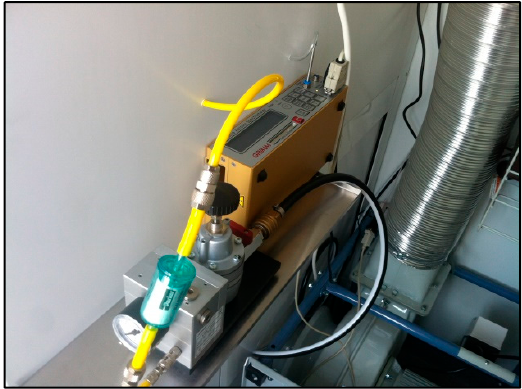
Figure 3. Aerosol spectrometer (yellow box) and pressure regulator with pressure indicator of the VKL mini. The dilution system VKL mini attenuates the sampled air in a ratio of 1:10 with neutral compressed air.